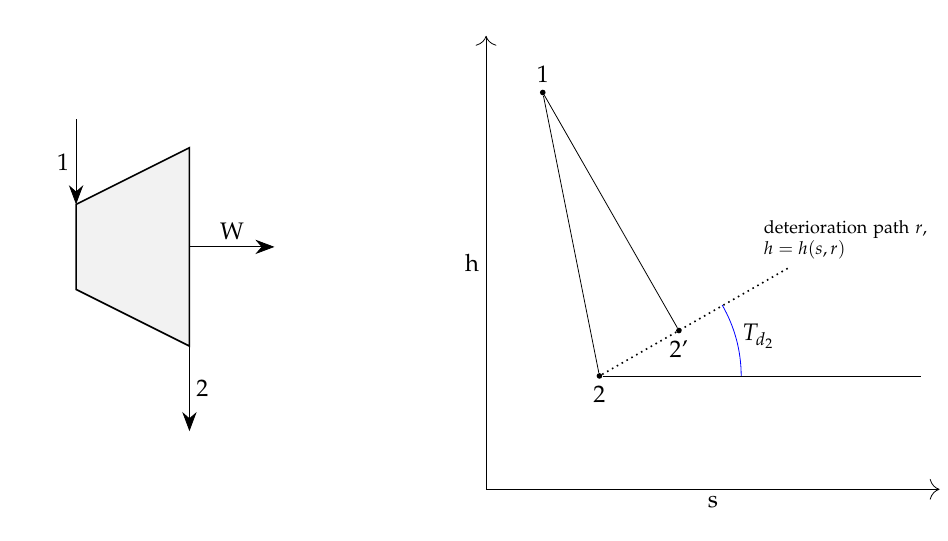
Figure 7. The deterioration path of a